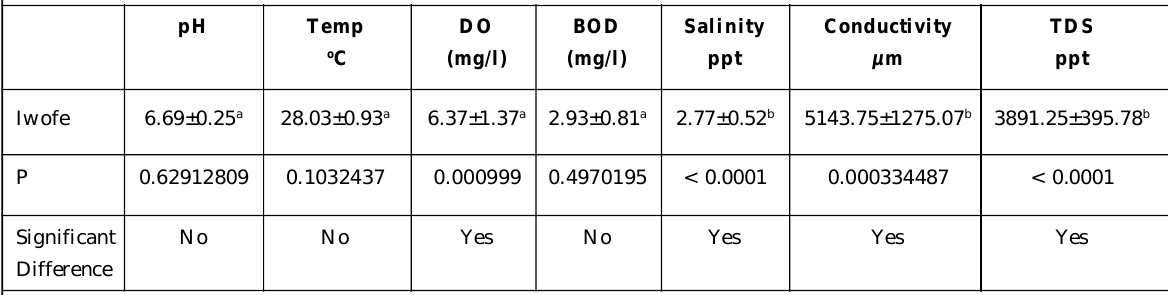
Table 1: Mean and SD of physical chemical parameters and results of Turkey separation of means